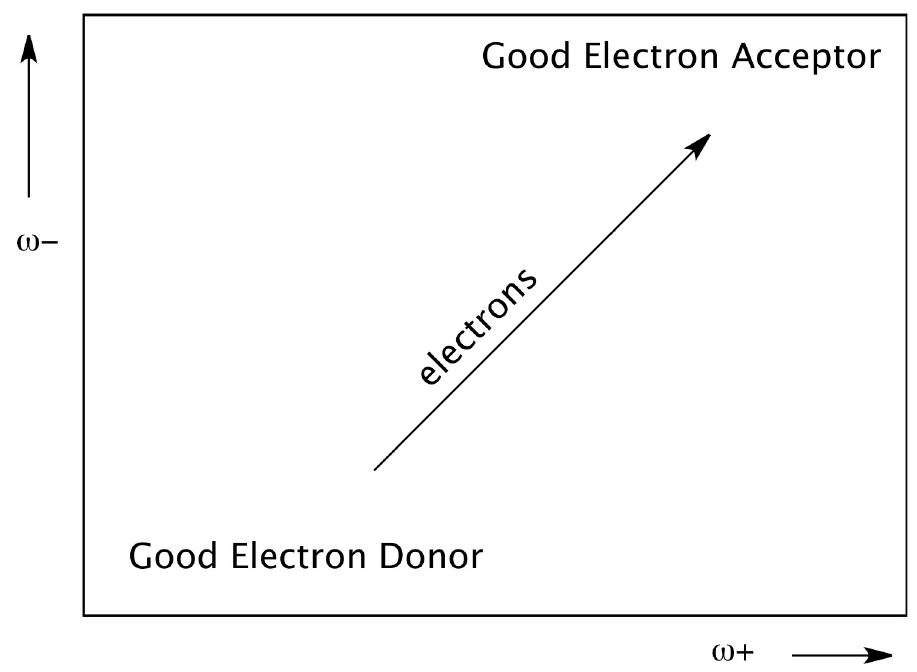
Fig 2. DAM. Donor-Acceptor